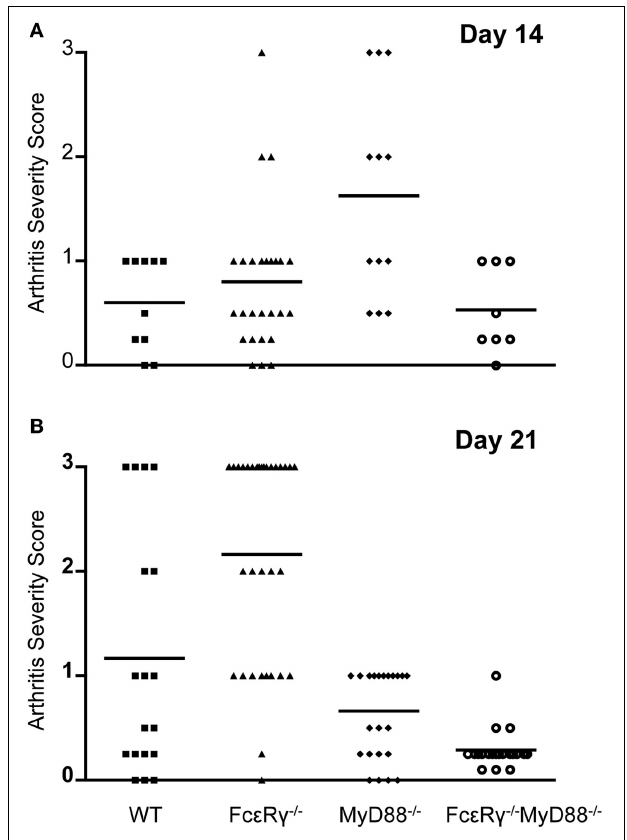
Table 1 | Prevalence of arthritis in B. burgdorferi infected mic a .